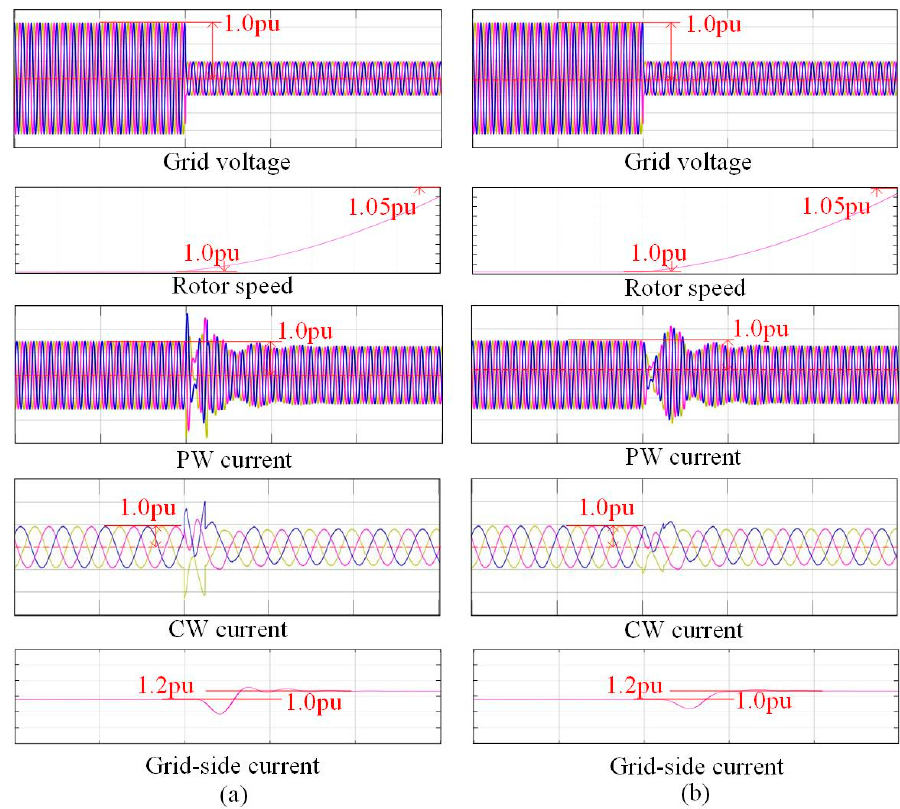
Figure 9. Comparison of waveforms when the grid has a 70% voltage drop with ( a ) existing VSC and ( b ) the proposed VSC ( t : 0.2 s/div).